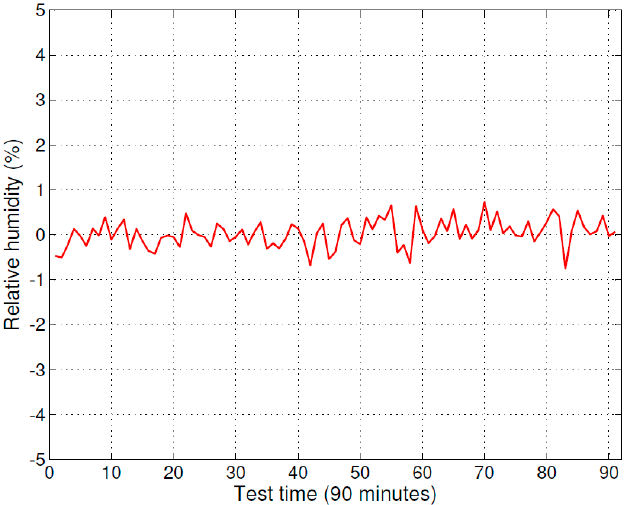
Figure 5. Difference of measurement value between the improved psychrometer and comparison instrument (HMP75).